Question: Based on the figure, does the quantity rise or fall?
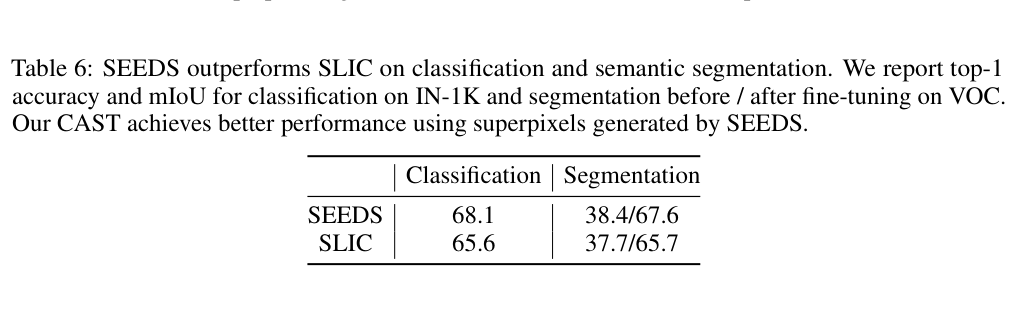
Answer: increasing